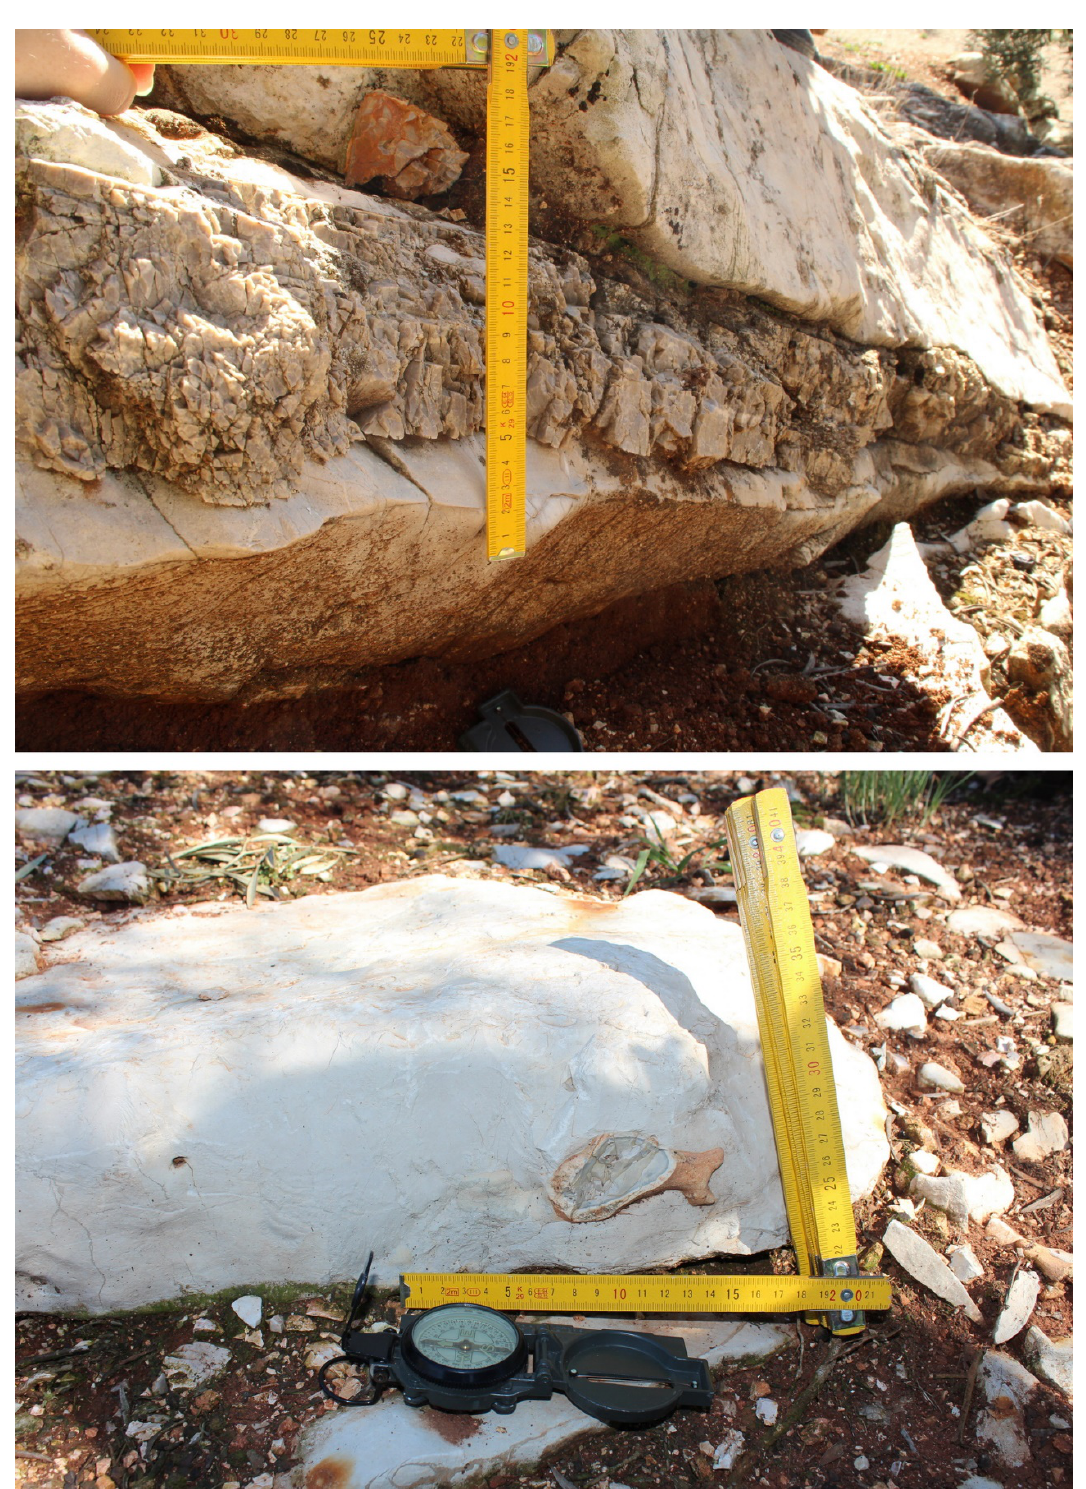
Figure 6. Primary outcrop of the Veleta Formation flint. Ruler segments are 20 cm